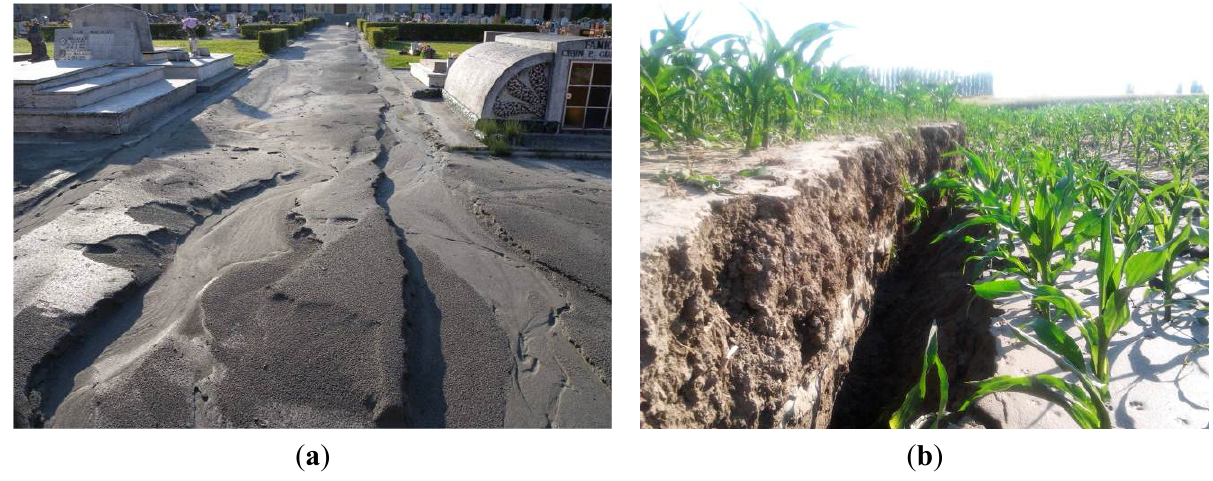
Figure 2. Soil liquefaction effects: ( a ) Sand volcano in a cemetery; ( b ) Surface